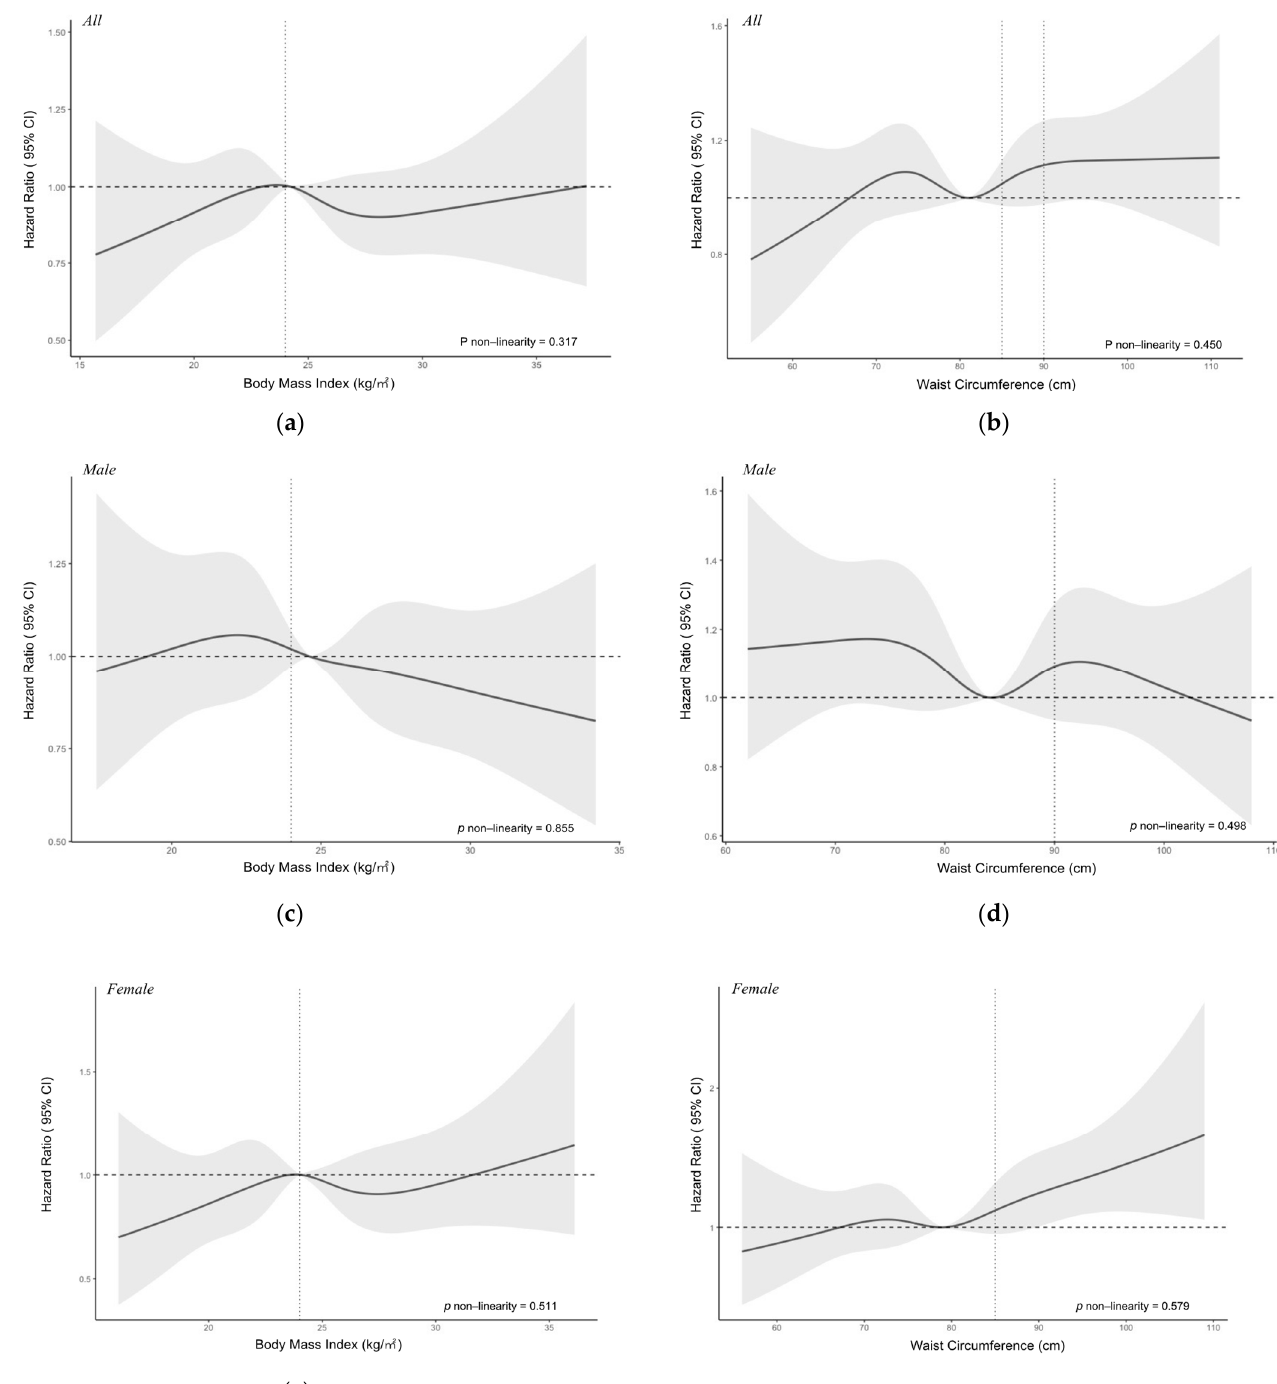
Figure 2. Nonlinear relationship of body mass index (BMI) and waist circumference (WC) with hyperhomocysteinemia among all subjects ( a , b ), male ( c , d ) and female subjects ( e , f ). Adjusted for age, gender, education, alcohol drinking, smoking, tea drinking, exercise, retirement status, cardiovascular disease comorbidities, and baseline blood creatine level. Y-axis represents the adjusted hazard ratio for the risk of Hyperhomocysteinemia for any value of BMI or WC. The black solid line represents the hazard ratio, and the grey shaded area represents the 95% confidence intervals. The horizontal dotted line represents the reference hazard ratio line y = 1. The vertical dotted line for the left graphs represents the cut-off value for BMI and WC.